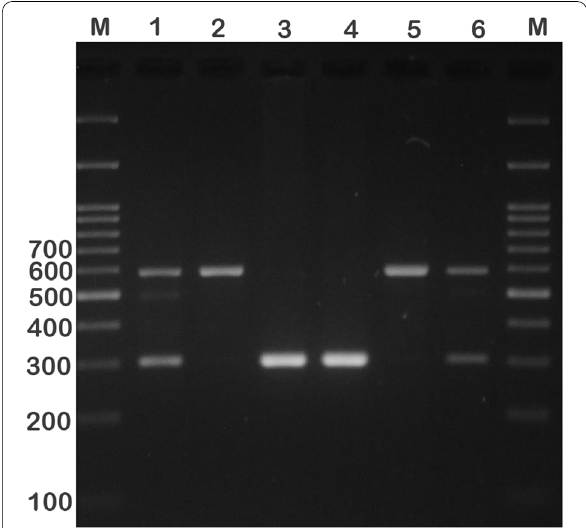
Fig. 1 Electrophoresis pattern of the PCR products for ACE rs4646994 indel polymorphism detection. M: DNA marker; Lanes 1, 6: ID; Lanes 2, 5: II; Lanes 3, 4: